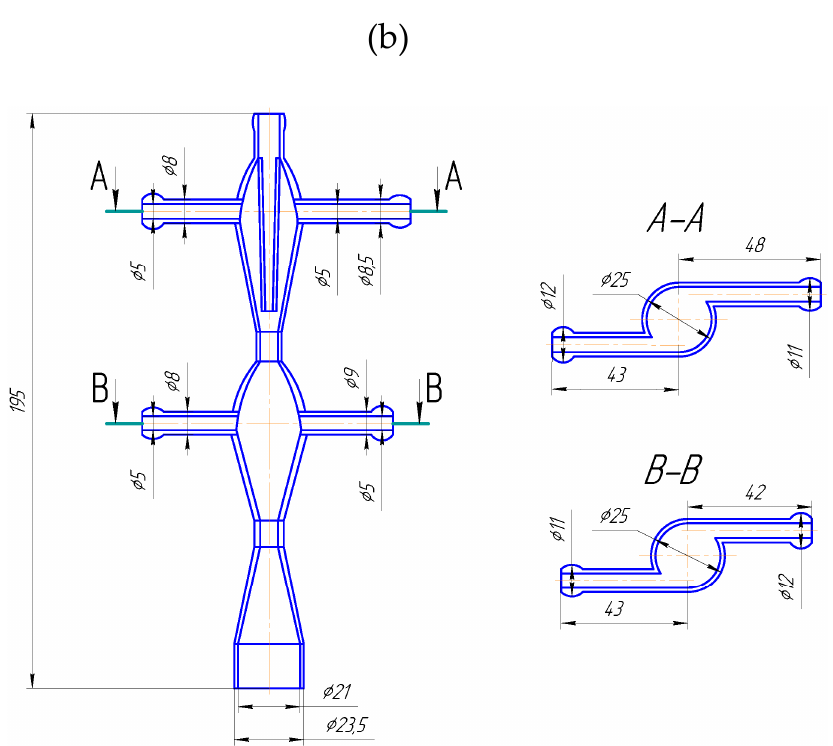
Figure 2. Schematic of two‑stage microreactor with intensively swirling flows ( a ) [8] and main sizes of the studied MRISF‑2 (in millimeters) ( b ). I—first stage; II—second stage; 1, 7—confusers of I and II steps; 2, 8—necks of I and II steps; 6, 9—diffusers of I and II steps; 3, 10—tangential inlet pipes; 4—axial inlet pipe; 5—nozzle; 11—outlet